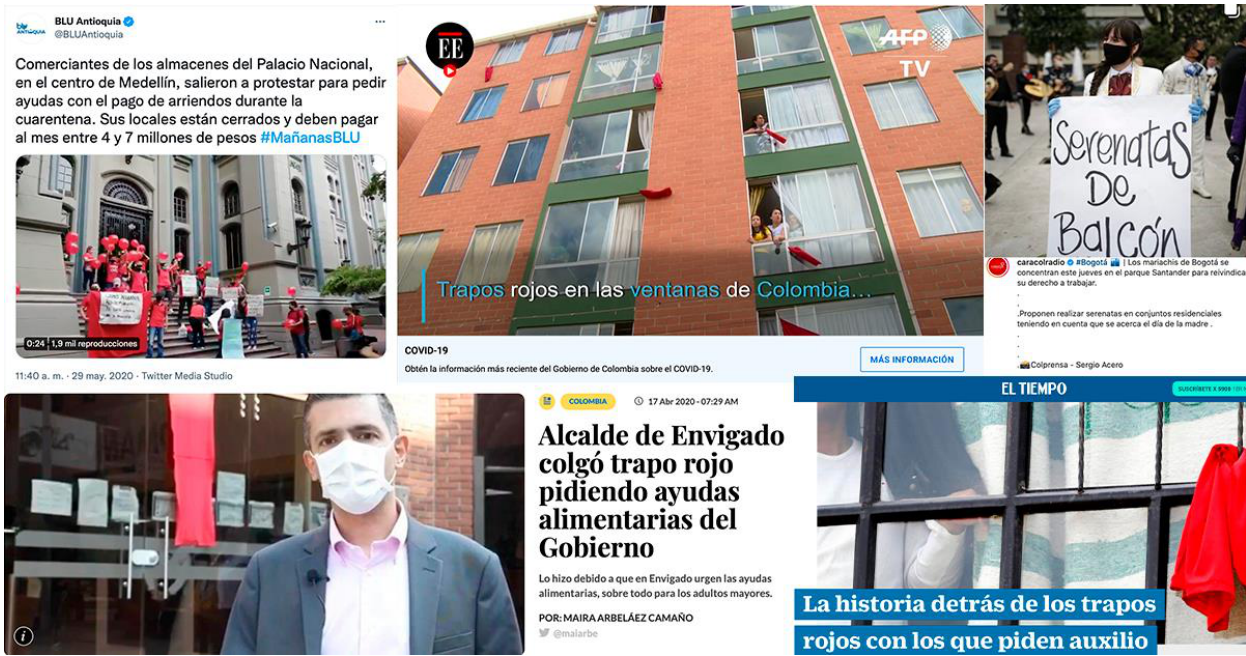
Figure 3. Messages issued in the study period. Source: prepared by the author with images extracted from digital